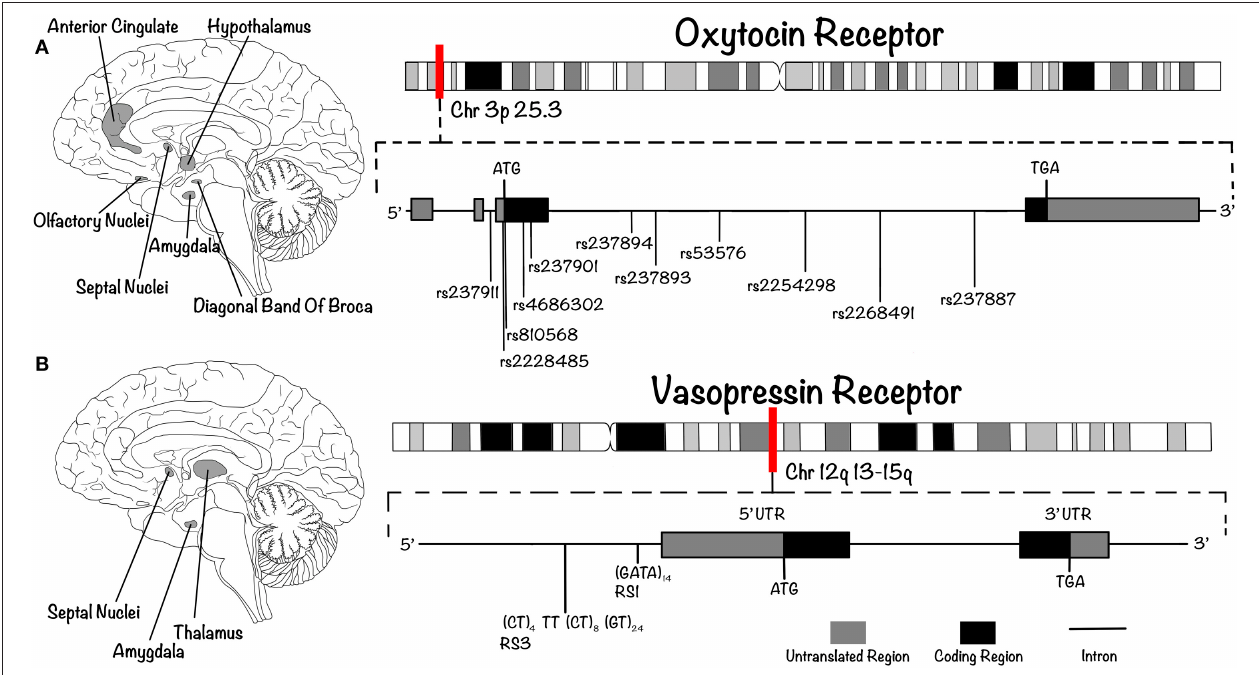
FIGURE 2 | OXTR and AVPR are G-protein coupled receptor expressed in key structures of the brain. Their genes present characteristic polymorphisms associated with differences in human social (and pathological) behaviors. (A) In the human brain, OXTR is expressed in the basolateral amygdala, the anterior and ventromedial hypothalamus, the olfactory nucleus, the diagonal band of Broca, the septal nuclei and the anterior cingulate (left). Its gene (right) is located on chromosome 3p25.3 (approximate position indicated by red vertical line). It contains four exons and three introns, which include several known SNPs. (B) AVPR1A is expressed in the septal nuclei, the thalamus and the basal amygdaloid nucleus (left); the gene encoding this receptor (right) is located on chromosome 12q14 (approximate position indicated by red vertical line). As in the case for OXTR, it contains an intron before the exon that encodes the seventh transmembrane domain. The schematic includes the SNPs (in the case of OXTR) and SSRs (in the case of AVPR) that are reviewed in this